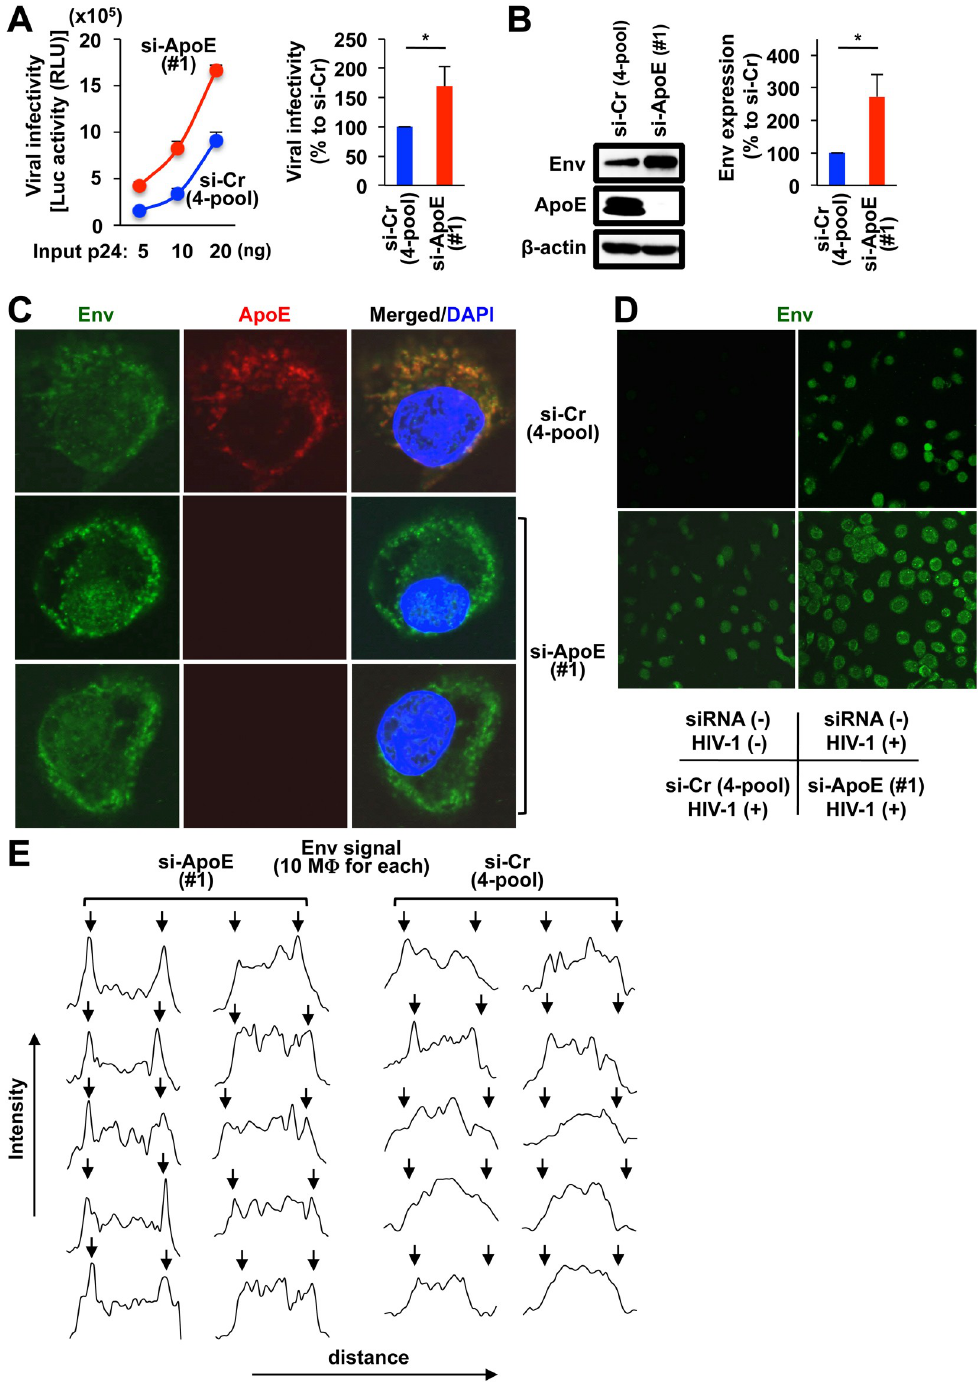
Fig 4. Effects of ApoE knockdown on infectivity of produced HIV-1 and localization of HIV-1 Env in MDMs. (A) MDMs were transfected with either ApoE siRNA #1 or pooled non-targeting siRNAs, cultured for 2 days, and infected with HIV-1 JR-FL (100 ng/mL p24). In the left panel, the supernatants were collected at 2 dpi, and the infectivity of the produced viruses was analyzed by the luciferase (Luc) reporter gene assay with TZM-bl cells, by changing the viral input (p24 amount) as indicated. RLU, relative light units. In the right panel, the infectivity of the viruses produced by ApoE siRNA-transfected cells are represented as percentages relative to that by control siRNA-transfected cells, and results for MDMs obtained from 3 donors are summarized. � p < 0.05. (B) MDMs were transfected and infected as in (A). In the left panel, the cell lysates were prepared at 2 dpi, and their levels of Env (gp160) were analyzed by western blot. ApoE levels